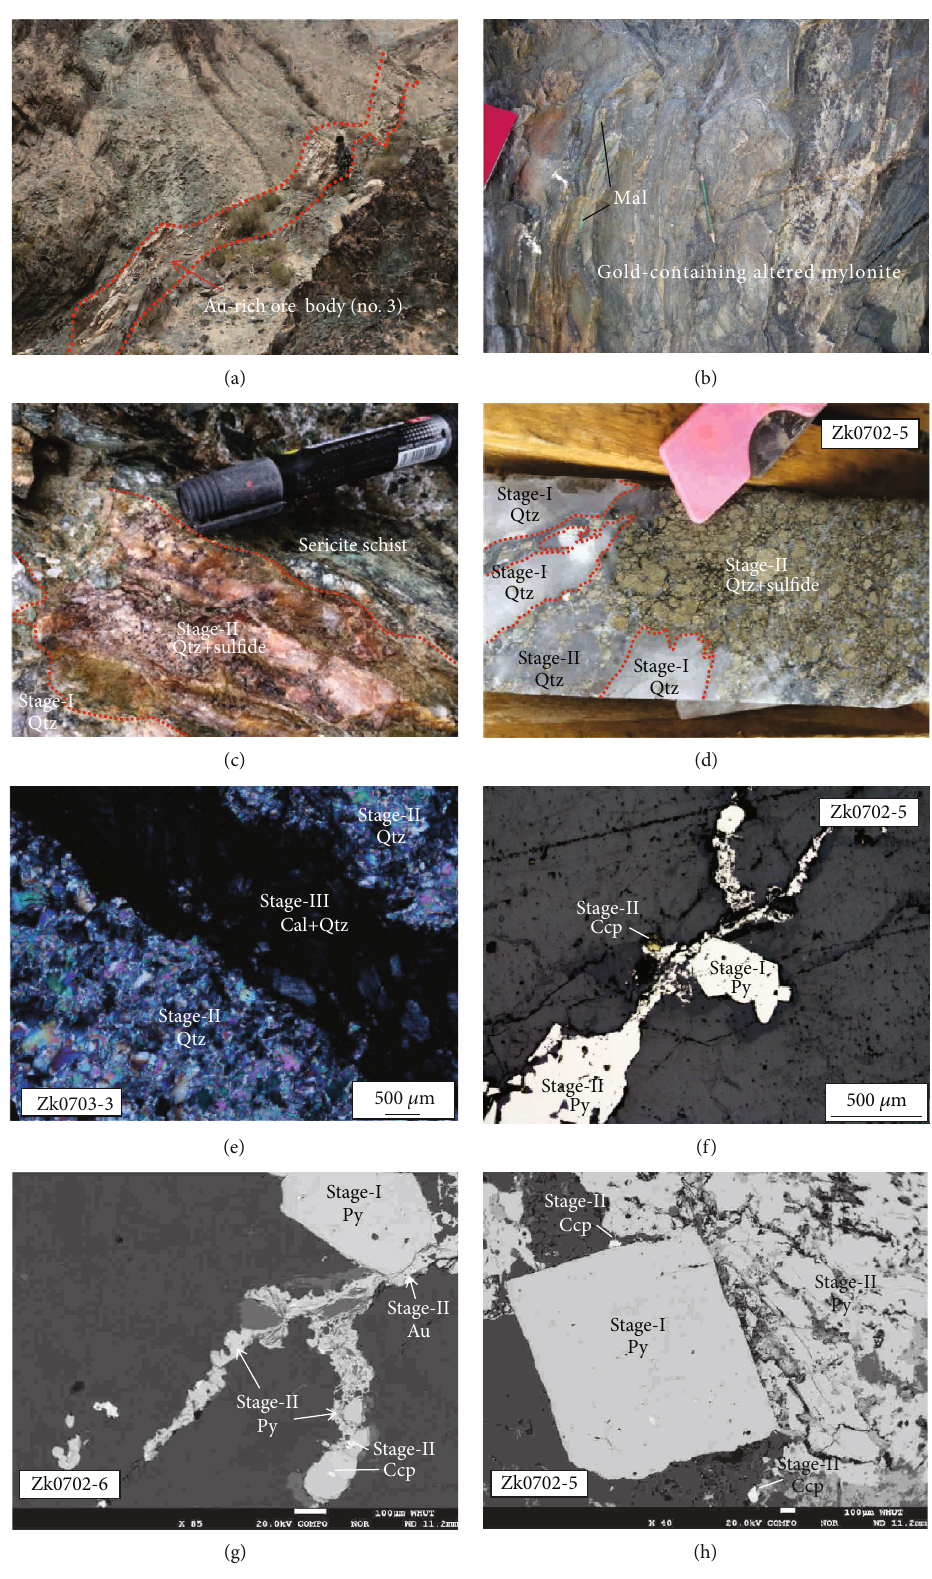
Figure 4: Photographs and photomicrographs of microstructures from the Yuka gold deposit. (a) Gold quartz vein. (b) Gold-containing altered mylonite. (c) Stage-II quartz and sericite schist. (d) Stage-I quartz and stage-II quartz. (e) Stage-II quartz and stage-III calcite +quartz. (f) Stage-I pyrite and stage-II pyrite with chalcopyrite. (g) Stage-II pyrite with native gold. (h) Cubic crystal stage-I pyrite. Abbreviation: Mal= malachite; Qtz = quartz; Py= pyrite; Ccp=chalcopyrite; Cal=